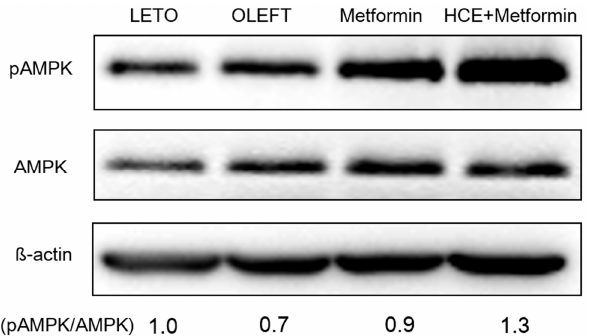
Figure 5. Impact of metformin either alone or in combination with HCE on the activation of hepatic adenosine monophosphate-activated protein kinase (AMPK) in OLETF rats as estimated by Western blotting. The density of the phospho-AMPK bands in the blot was quantified by densitometric analysis and normalized to the amount of non-phospho form of AMPK.